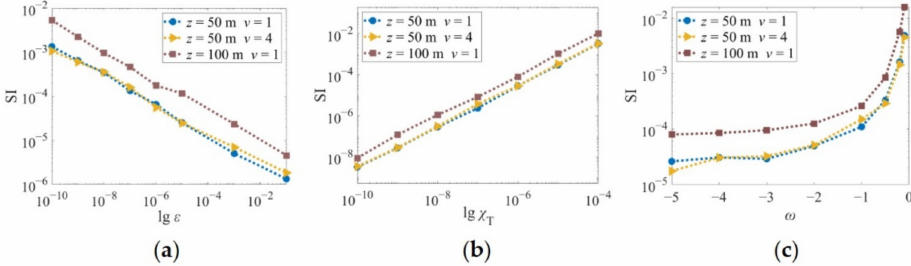
Figure 11. Light scintillation index versus ( a ) lg ε , ( b ) lg χ T , and ( c ) ω with different flow velocities and transmission